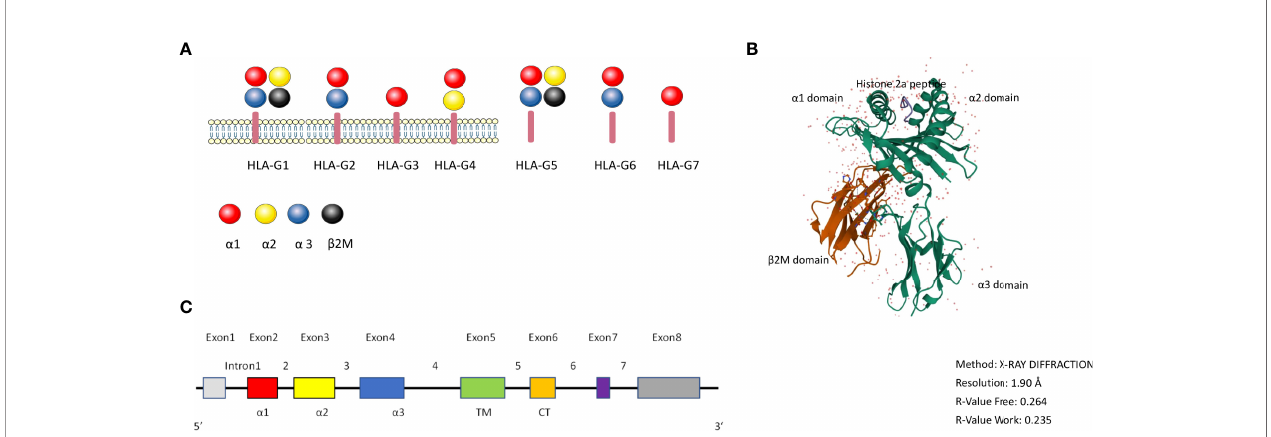
FIGURE 1 | the HLA-G molecule. (A) : Schematic overview of the HLA-G isoforms. HLA-G1 to G4 are membrane bound isoforms and HLA-G5 to G7 are soluble isoforms, they are generated by alternative splicing. HLA-G1 and G5 complex contain a 1 (red color), a 2 (yellow color), and a 3 (blue color) globular domains non- covalently associated with b 2-microglobulin (black color). (B) : 3D crystal structure of HLA-G (reproduced from Protein Data Bank (Gene ID: 1YDP) with permission. The heavy chain (hc) is shown in green, b 2M in red, and the peptide in blue color. (C) : HLA-G gene structure. Exon 1 encodes the signal peptide. Exons 2, 3, and 4 encode the a 1, a 2, and a 3 domains, respectively. Exons 5 and 6 for the transmembrane (TM) and cytoplasmic (CT) domains, respectively. Exon 7 and exon 8 are not